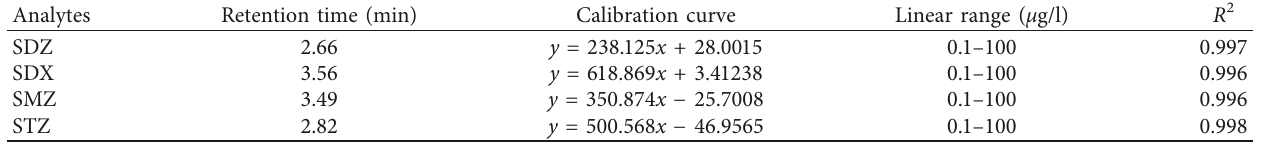
Table 1: Retention times, matrix calibration curve, and linear range of the four SAs (LC–MS/MS). Analytes